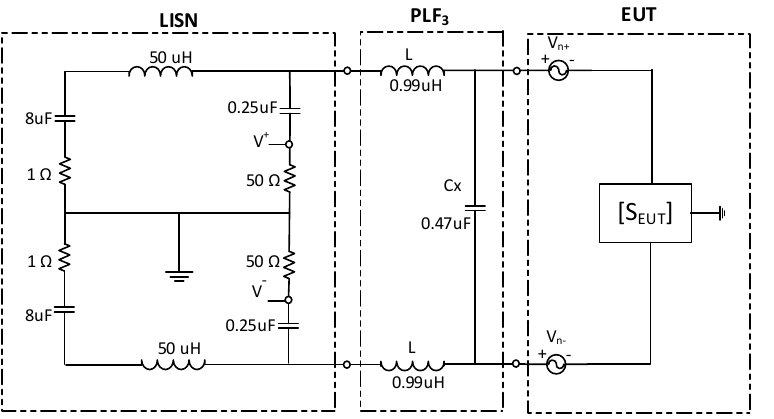
Figure 18. PLF connected between the EUT and the LISN consisting of a DM inductor and an X-type capacitor.